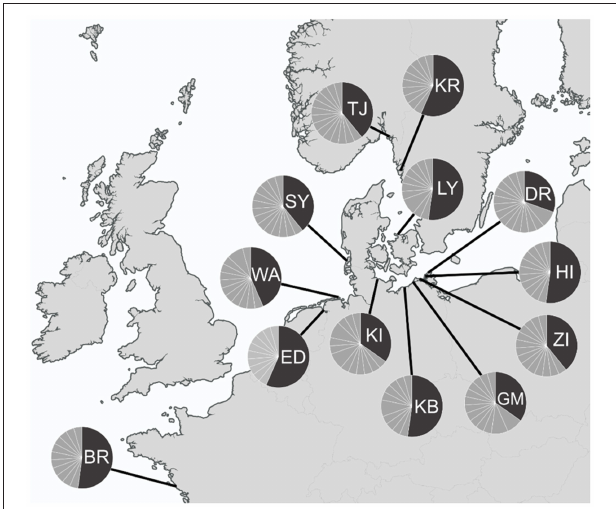
FIGURE 1 | Sampling sites with COI haplotypes frequencies per sampling site. Dark gray: the most common haplotype Tn1, light gray: all other haplotypes. BR, Brittany; ED, Emden; WA, Wangerooge; SY, Sylt; TJ, Tjärnö; KR, Kristineberg; LY, Lynaes; KI, Kiel; KB, Kühlungsborn; GM, Graal-Müritz; ZI, Zingst; HI, Hiddensee; DR, Dranske.